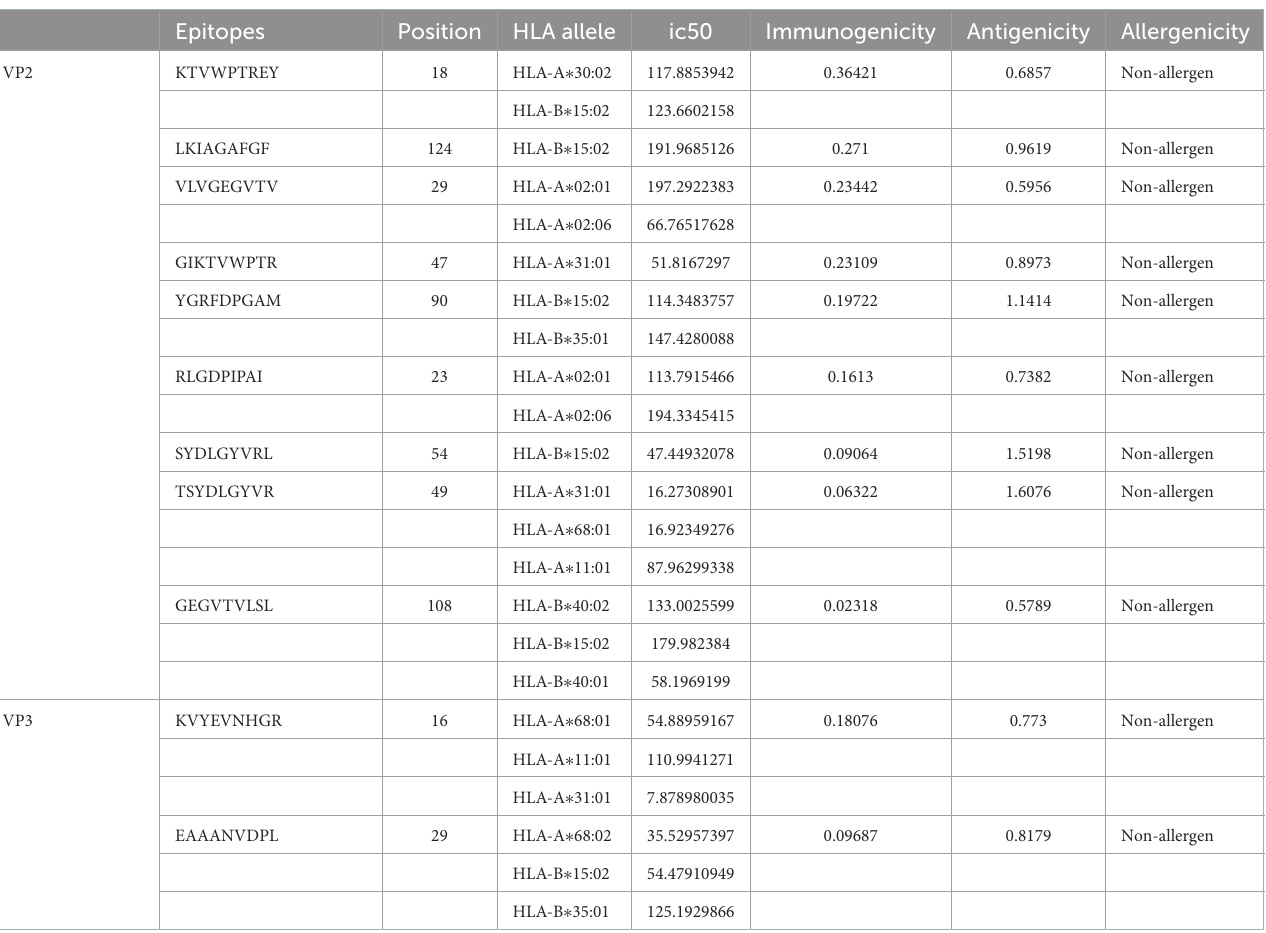
TABLE 1 Final predicted cytotoxic T cells (CD8 + /CTL) epitopes.